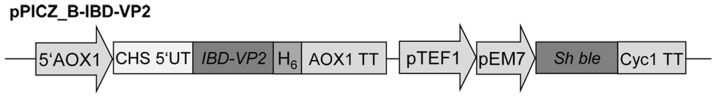

Pichia pastoris expression cassette in pPICZ_B (Invitrogen).Abbreviations: 5′AOX1 and AOX1 TT, methanol-inducible alcohol oxidase 1 gene promoter and terminator, respectively; CHS 5′-UT, untranslated region of the Petroselinum hortense chalcone synthase gene; IBD-VP2, cDNA of Infectious bursal disease virus protein 2, corresponding to the first 441 amino acids; H6, His-6 tag for detection and purification; pTEF1, transcription elongation factor 1 gene promoter from S. cerevisiae that drives expression of the Sh ble gene in P. pastoris conferring zeocin resistance; pEM7, constitutive synthetic prokaryotic promoter that drives expression of the Sh ble gene in E. coli; Sh ble, Streptoalloteichus hindustanus bleomycin resistance gene; Cyc1 TT, CYC1 transcription termination region (GenBank accession number M34014), the 3′ end of the S. cerevisiae CYC1 gene that allows efficient 3′ mRNA processing of the Sh ble gene for increased stability.